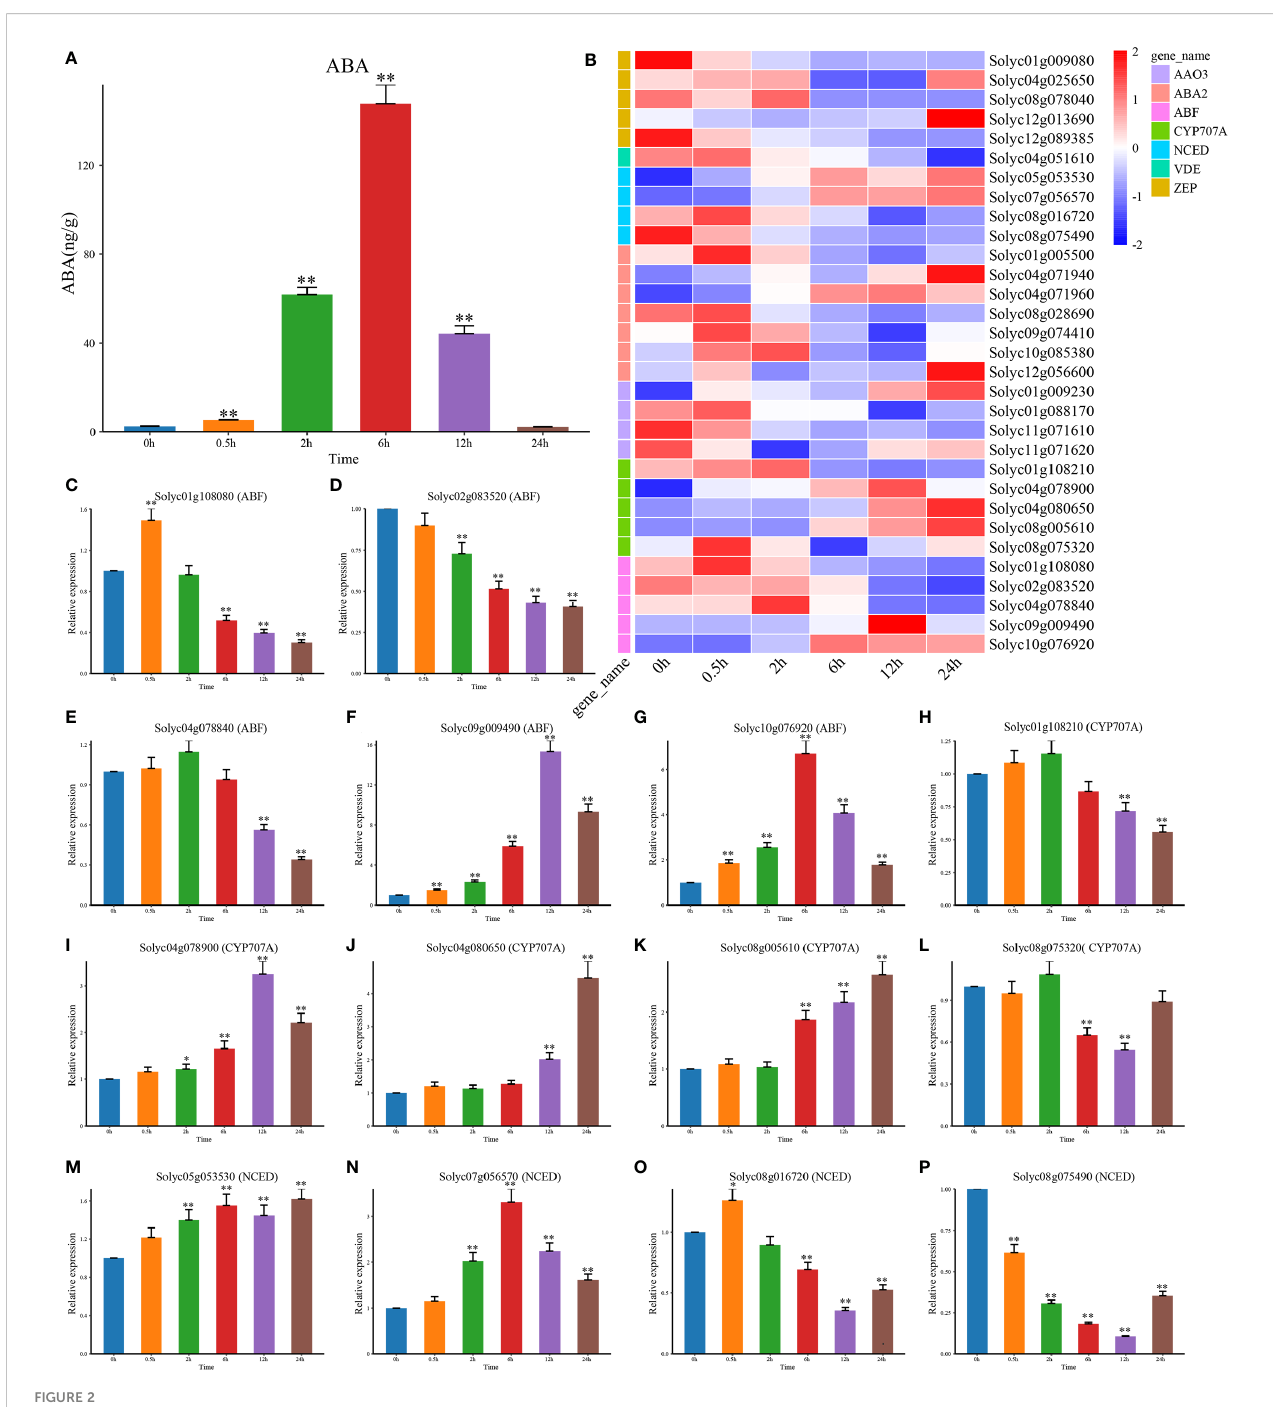
FIGURE 2 The content of hormone ABA and the NaCl treatment ’ s effects on the expression patterns of the genes involved in ABA biosynthesis and signal transduction. (A) The level of the hormone ABA at DTP under salt stress (B) Following the NaCl treatment, the expression pro fi les of DEG involved in ABA biosynthesis and signal transduction at DTP (C – P) The expression patterns of CYP707A, NCED, and ABF at DTP under salt stress. (*P-value < 0.05; **P- value <